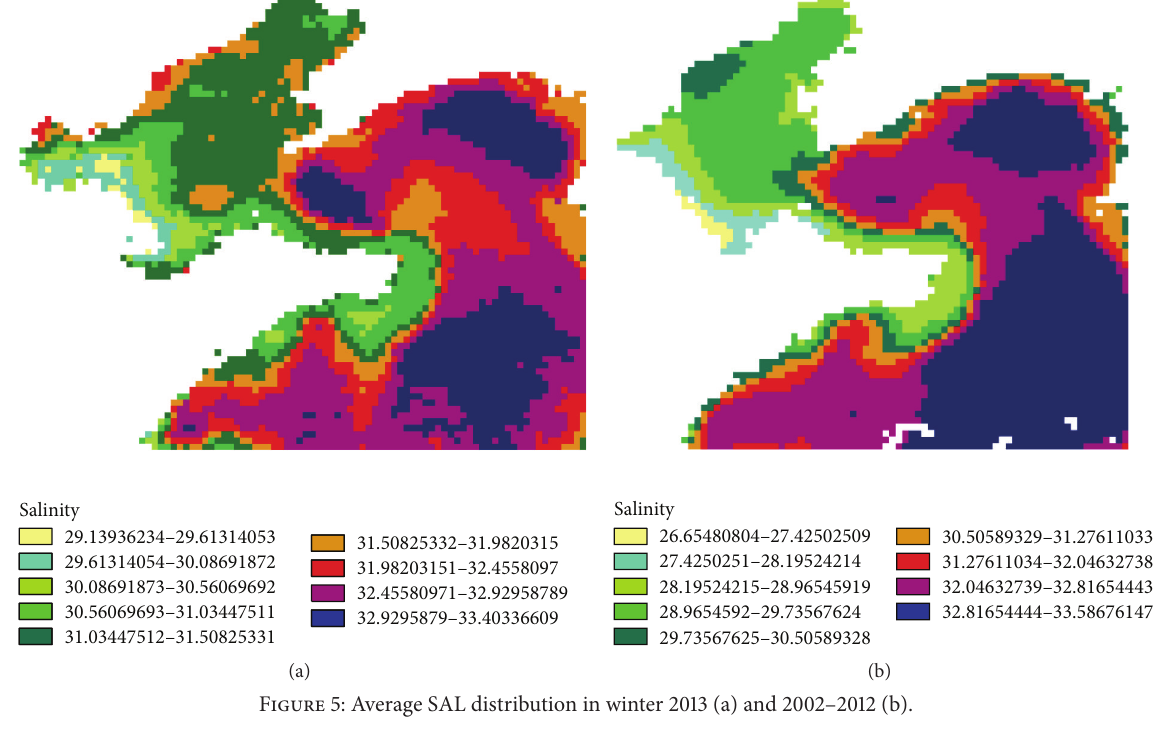
Figure 5: Average SAL distribution in winter 2013 (a) and 2002–2012 (b).